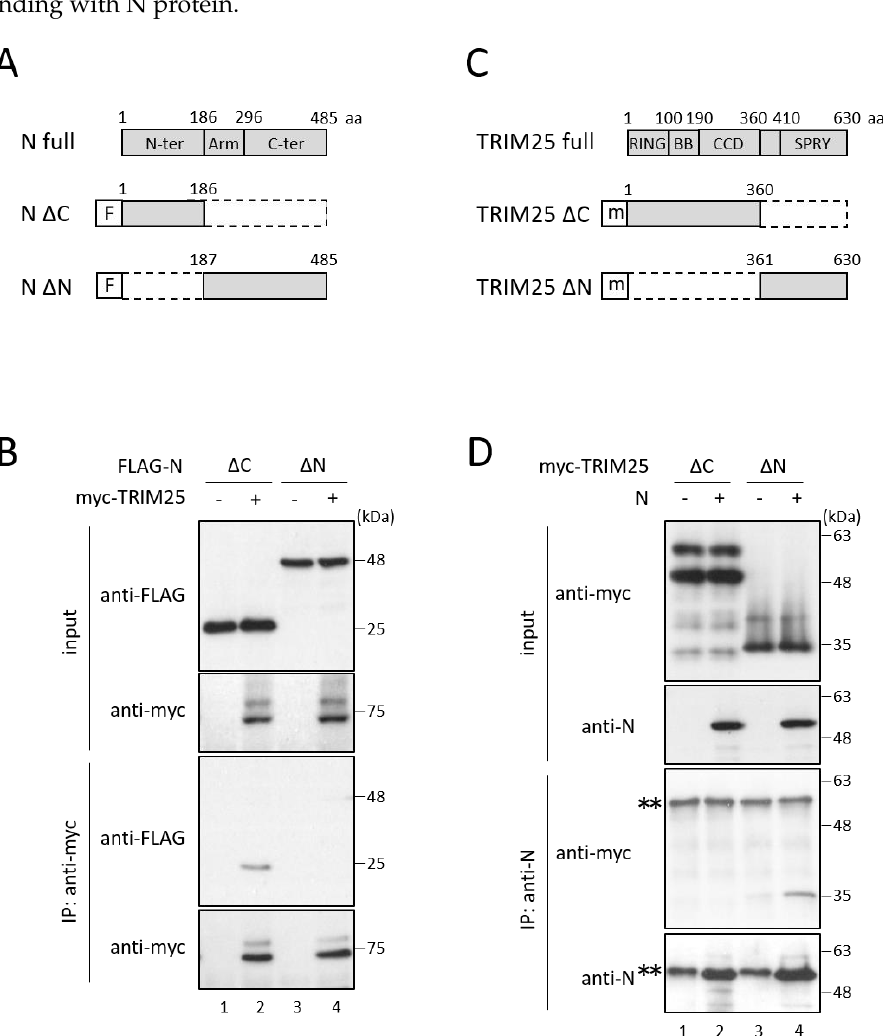
Figure 3. Identification of regions important for the interaction between N protein and TRIM25. ( A , C ) Schematic diagrams of ( A ) full-length N protein and its deletion mutants and ( C ) full-length TRIM25 and its deletion mutants. “F” and “m” indicate FLAG tag and myc tag, respectively. ( B , D ) COS cells were transfected with various combinations of the indicated plasmids. After 48 h, cell lysates were analyzed by immunoblot and immunoprecipitation assays (Figure 2). Double asterisks indicate immunoglobulin heavy chains.